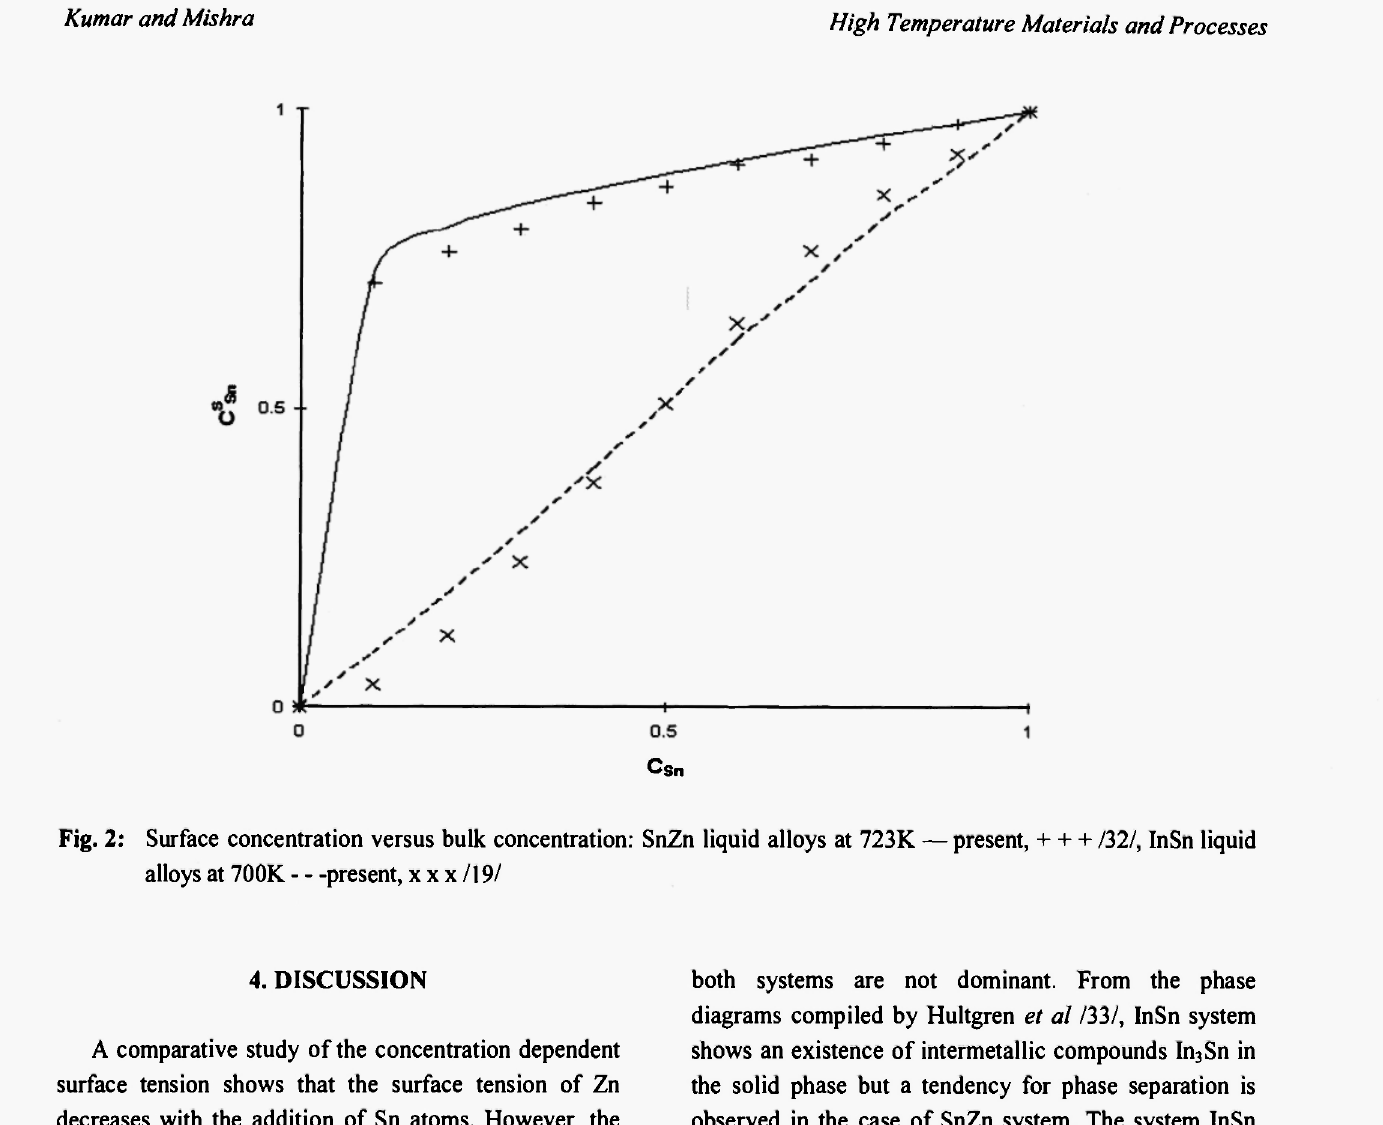
Fig. 2: Surface concentration versus bulk concentration: SnZn liquid alloys at 723K — present, + + + /32/, InSn liquid alloys at 700K - - -present, χ χ χ